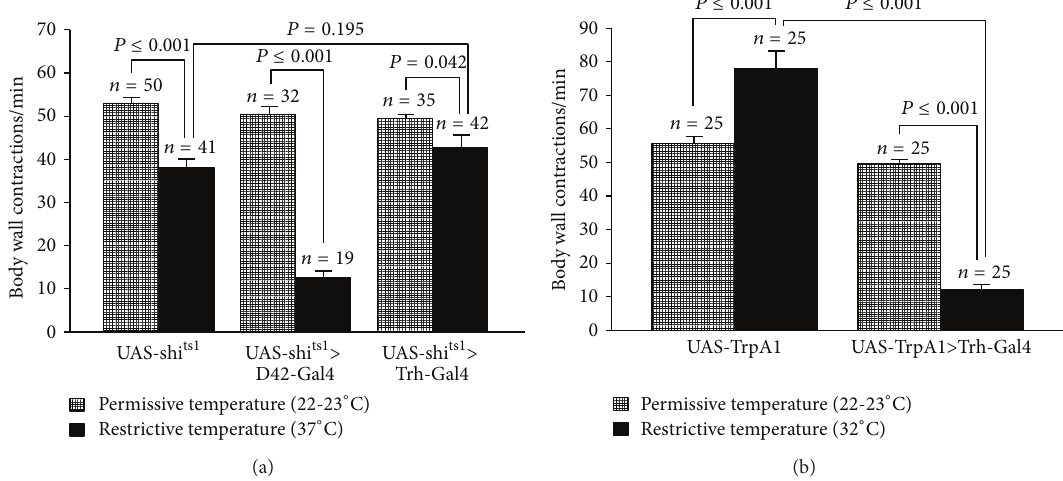
Figure 9: Acute manipulation of 5-HTergic neurons activity by shi ts1 and TrpA1. (a) Synaptic transmission was blocked in the 5-HTergic neurons by expressing dominant negative temperature sensitive shibire ts1 allele ( shi ts1 ). Suppression of synaptic transmission in motor neurons (UAS- shi ts1 > D42-Gal4) significantly reduced body wall contractions; however, suppression of synaptic transmission in 5-HT neurons (UAS- shi ts1 > Trh-Gal4 (III)) did not significantly influence body wall contractions. The flies were raised at 23 ∘ C, 12 :12 LD cycle. To obtain the locomotion behavior at room temperature for control and shibire ts1 expressing larvae, an individual third-instar larva was placed on the apple-juice agar. The larva was left for 1min to acclimate, and body wall contractions were counted for the following 1min. To obtain body wall contractions at restrictive temperature for control and shibire ts1 expressing larvae, the larvae were incubated at 37 ∘ C for 20min. The individual larvae were placed on prewarmed apple-juice agar on hot plate (30–32 ∘ C). The larva was left for 1min to acclimate, and the body wall contractions were counted for the following 1 min. (b) Thermogenetic approach was used to activate 5-HTergic neurons. When TrpA1 channels are exposed to high temperature (32 ∘ C), they become activated which leads to inward current flux of cations. Activation of 5- HTergic neurons (UAS-TrpA1 > Trh-Gal4 (III)) significantly decreases BWCs compared to control larvae (UAS-TrpA1). To obtain BWCs at room temperature, larvae were placed on apple-juice agar dish at room temperature and left for 2min to acclimate. Afterwards, BWCs were counted for 1min. The locomotor behavior at restrictive temperature (32 ∘ C) was obtained by placing one larva on a prewarmed apple-juice agar dish on a hot plate (32 ∘ C). The larvae were left for 2 min, and then the BWCs were counted for 1min. Student’s 𝑡 -test was performed to carry out comparison between groups. Data presented as mean ± SEM. 𝑃 < 0.05 is